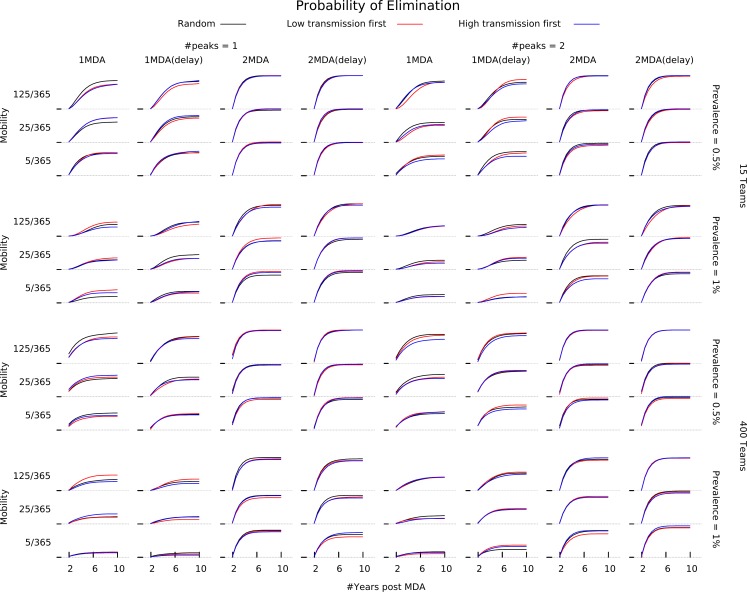
Relationship between elimination probability and MDA campaign village sequencing.Shows how the relationship between human population mobility (rows), seasonality patterns (blocks of columns), MDA operational parameters – number of teams (block of rows), campaigns and campaign start time (columns) – and selection for the starting villages for MDA (colors) influences the probability of malaria elimination (y-axis).